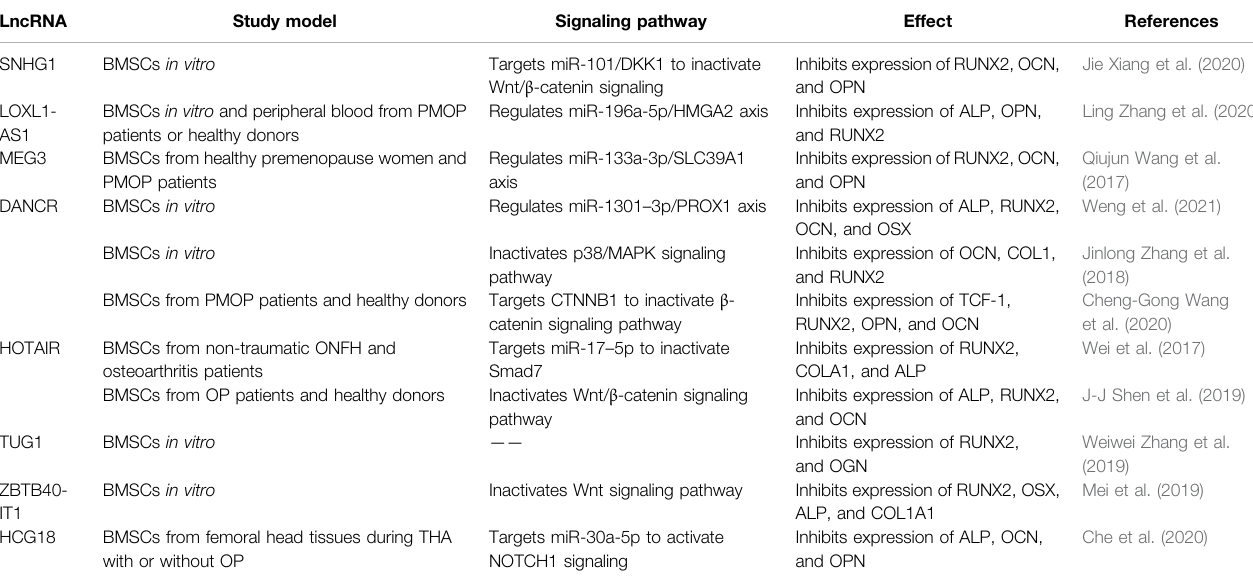
TABLE 4 | LncRNAs that inhibit osteogenic differentiation of BMSCs and underlying